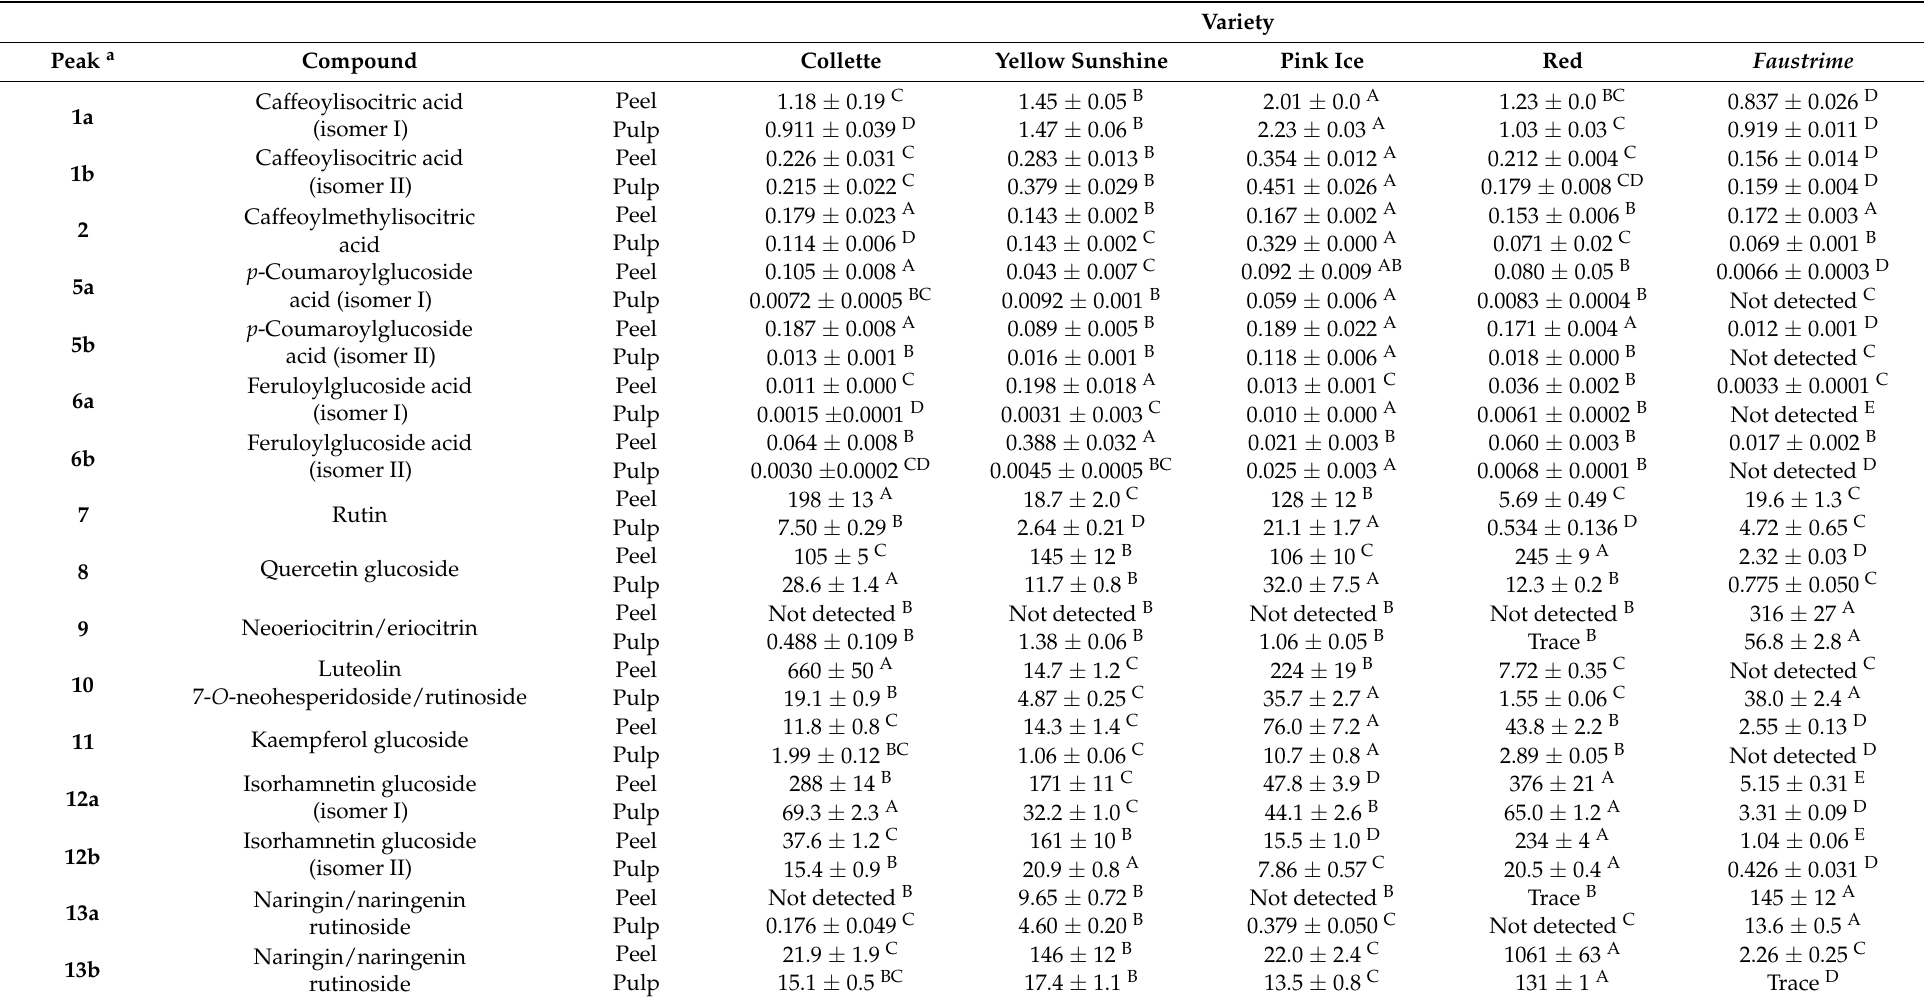
Table 3. Content of phenolic compounds ( µ g/g of dried peel or pulp ± standard deviation) and anthocyanins ( µ g/g of fresh peel or pulp ± standard deviation) in C. australasica peel and pulp extracts. nd = not